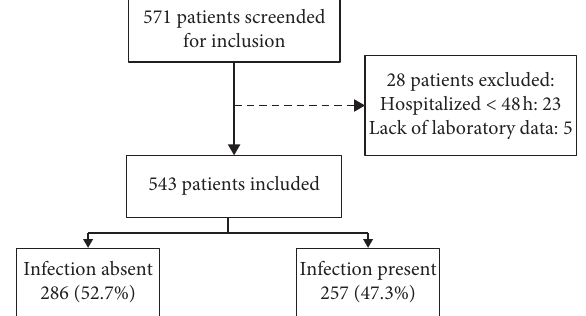
Figure 1: Flow-chart of the patients evaluated for inclusion, reasons for exclusion, and the final sample according to the presence of infection at initial evaluation. Table 1: Characteristics of included patients and comparison according to the presence of SIRS. All ( n �